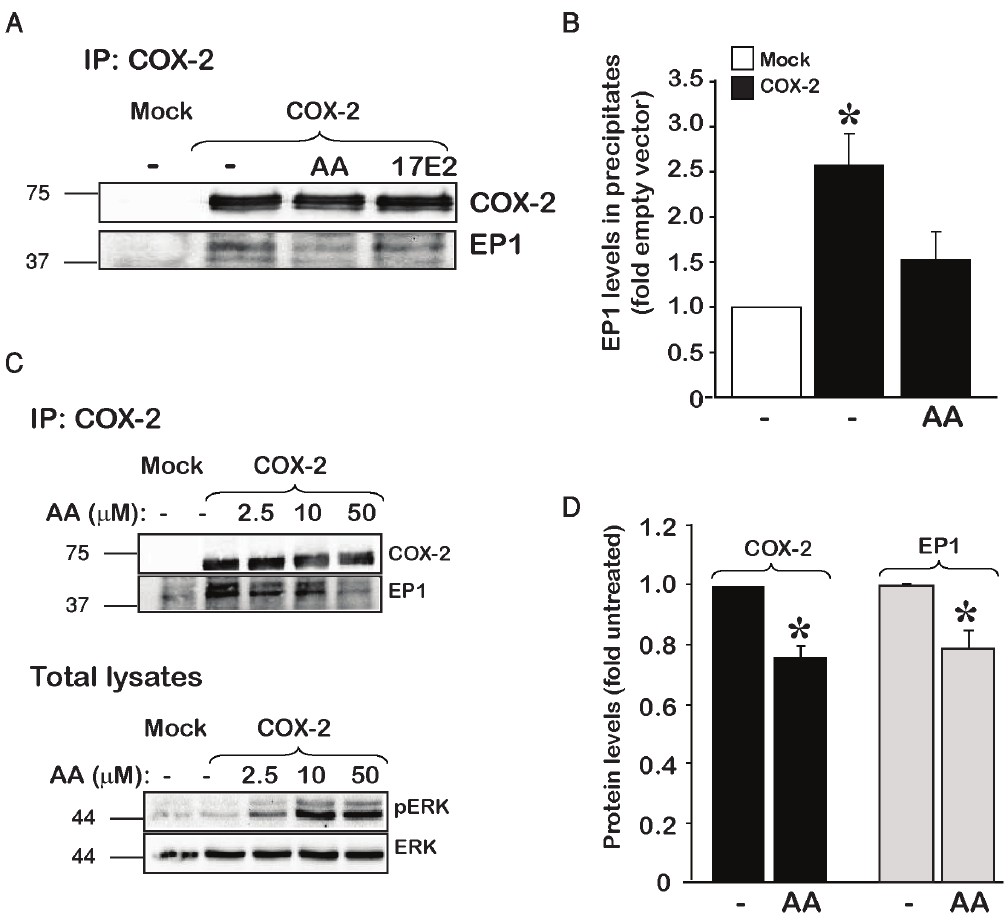
Figure 2. The interaction between COX-2 and EP 1 is disrupted in the presence of AA. A , COX-2 was immunoprecipitated from HEK 293 cells, transfected with Mock or COX-2 and treated with either vehicle (ethanol), AA (50 m M) or the EP 1 agonist 17E 2 (1 m M) for 15 min. Blots were probed for COX-2 and EP 1 using specific antibodies. B , Summary graph of n=5 independent experiments showing a reduction in the levels of EP 1 co- immunoprecipitated with COX-2 following treatment with AA. *p , 0.05 vs. Mock transfection. C , Representative immunoblot of n=3 independent experiments depicting the dose-dependent effect of AA on the interaction of COX-2 with EP 1 . Cells were transfected with either mock or COX-2, and 16 h post-transfection treated with 2.5, 10 or 50 m M AA for 15 min prior to immunoprecipitation. Immunoprecipitate were probed for COX-2 and EP 1 levels. Total lysates from the same samples were probed first for phosho-ERK followed by total ERK levels using specific antibodies. D , prolonged exposure to AA, reduces COX-2 and EP 1 levels. Cells overexpressing COX-2 were treated with 10 m M AA for 1.5–2 h, samples were collected and probed for levels of COX-2 and EP 1 . n=5 independent experiments, *p , 0.05 vs. untreated.